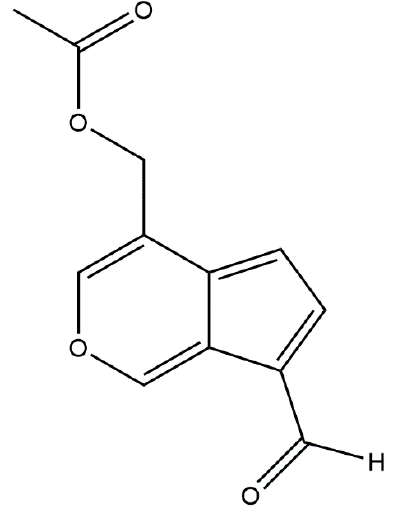
Figure 1. Structure of Baldrinal (BAL).